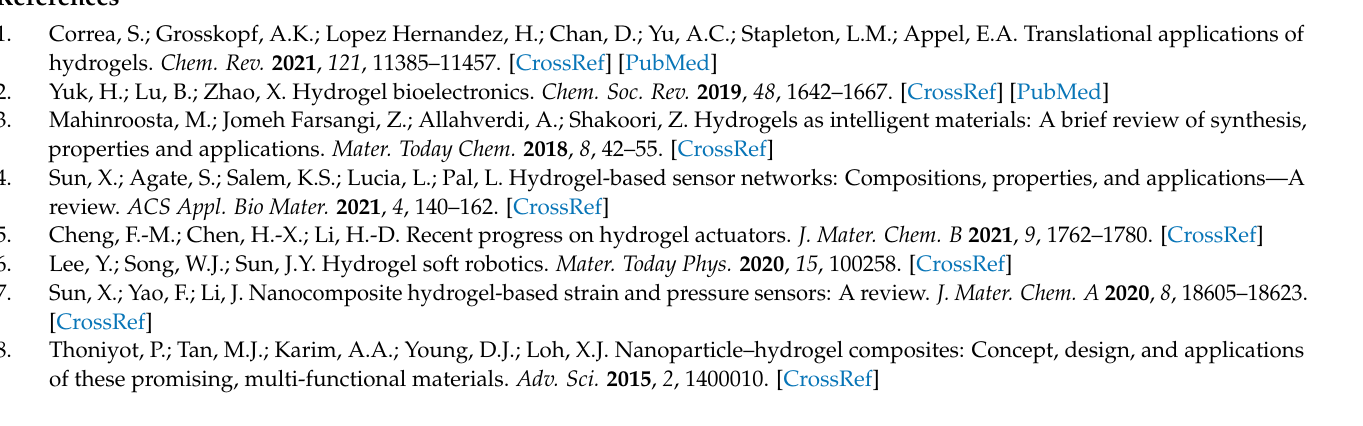
D 2 O; Figure S2: 1 H NMR spectrum of PImQ in D 2 O; Figure S3: 13 C NMR spectrum of PIm in D 2 O; Figure S4: 13 C NMR spectrum of PImQ in D 2 O; Figure S5: A 660 values of a PImQ/graphene (0.5:1 ( w/w )) suspension plotted against storage time; Figure S6: TGA profiles of (a) graphite and PImQ and (b) PImQ/graphene (0.5:1 ( w/w )) obtained at a heating rate of 5 ◦ C min − 1 under nitrogen; Figure S7: Zeta potentials of (a) PImQ and (b) PImQ/graphene (0.5:1 ( w/w )) in water; Figure S8: Effects of PImQ/graphene concentration on Young’s moduli for nanocomposite hydrogels (tensile strain of 300%, at 25 ◦